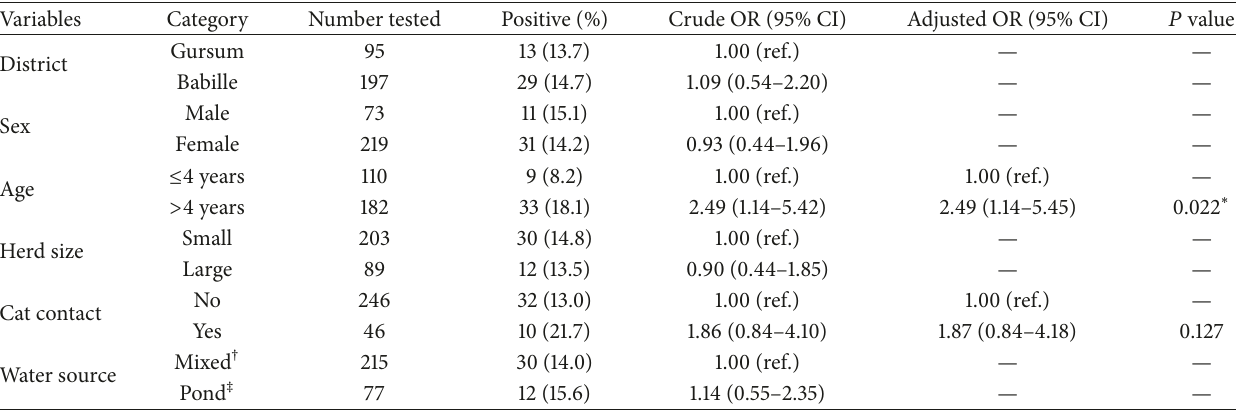
Table 5: Analysis of risk factors with T. gondii seropositivity in camels at animal level ( 𝑛 = 292